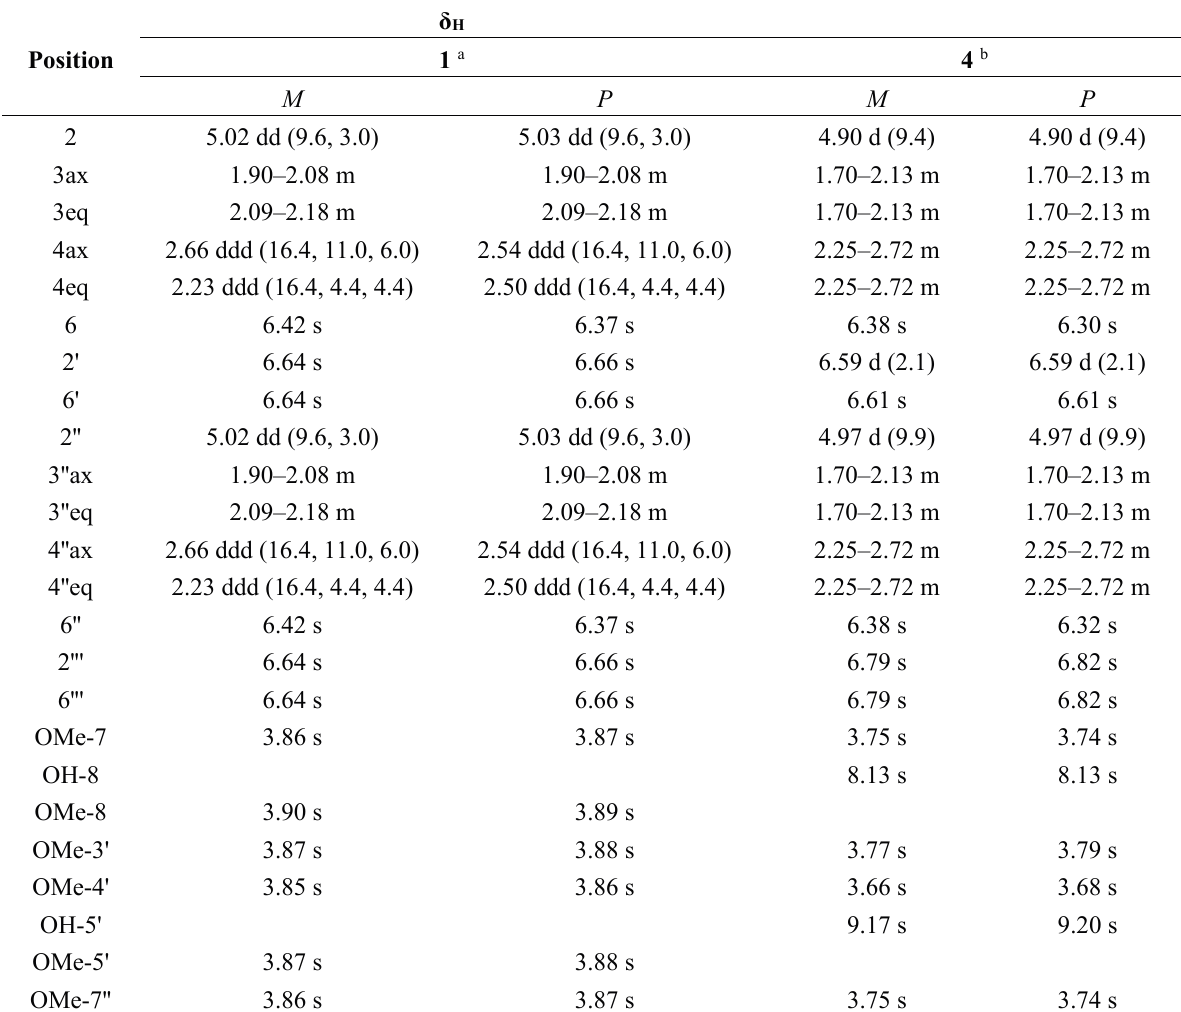
Table 1. 1 H-NMR data of 1 and 4